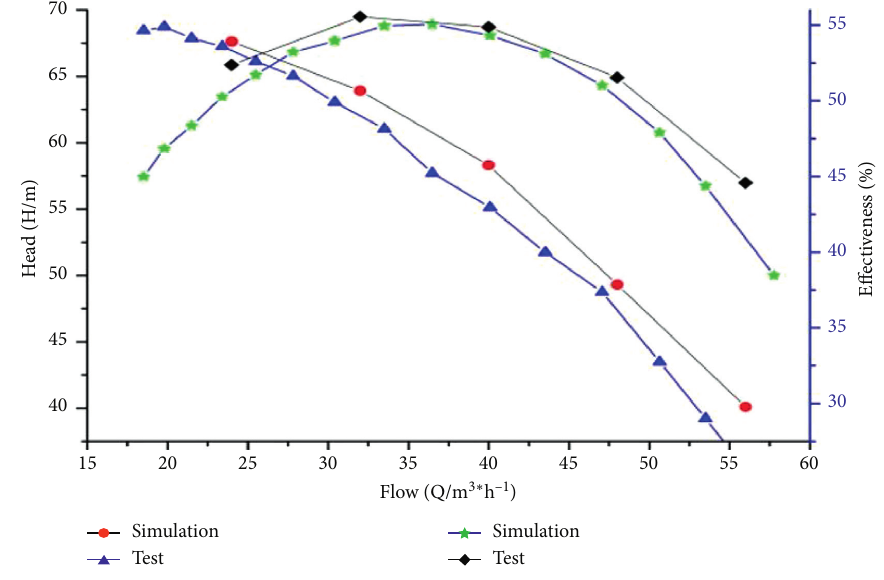
Figure 3: Head efficiency flow